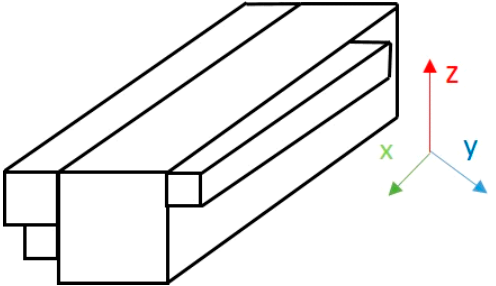
Figure 6. A bundle of capillary tubes used for studying confined phase behavior with pore size distribution.